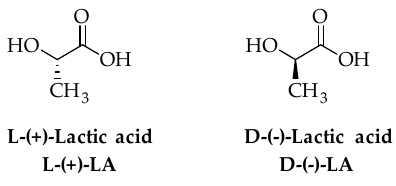
Figure 1. Structure of enantiomers of LA.